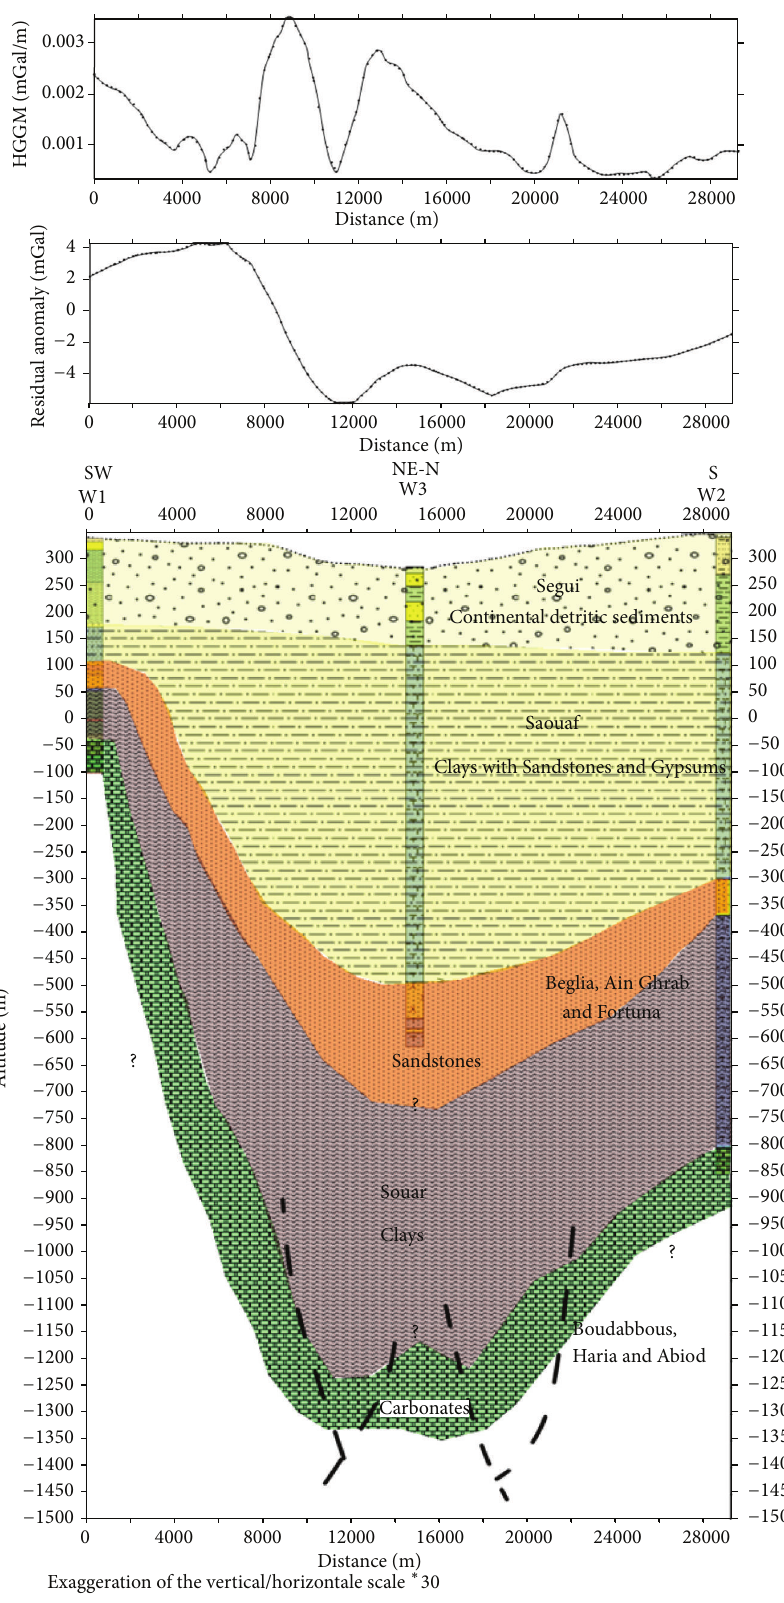
Figure 8: Subsurface structureof the study area using a hydrostratigraphic cross sections linking hydraulic well (W1, W2, and W3), horizontal gradient gravity magnitude, and residual gravity anomaly